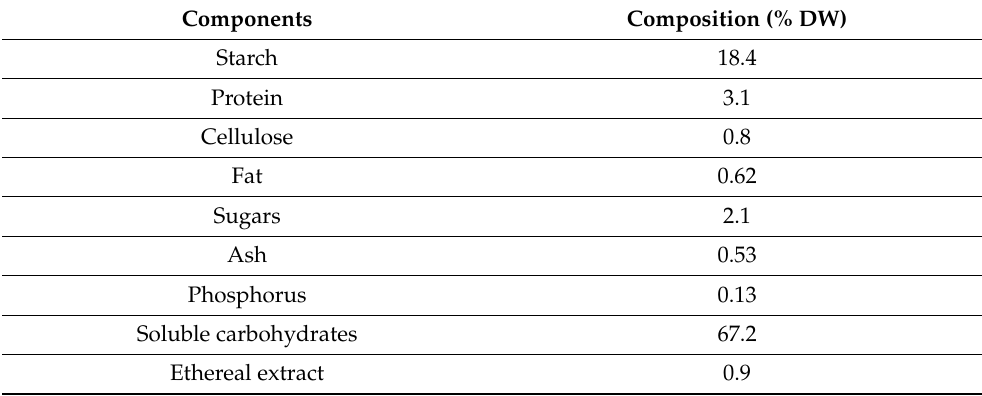
Table 5. Chemical composition of banana pulp on a dry basis